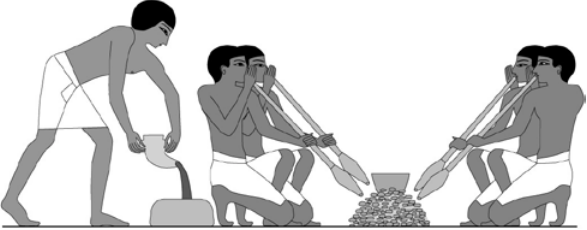
Figure 3. Extraction of Copper (malachite mixed with charcoal heated with blowpipes and then pouring of the molten copper as shown on the